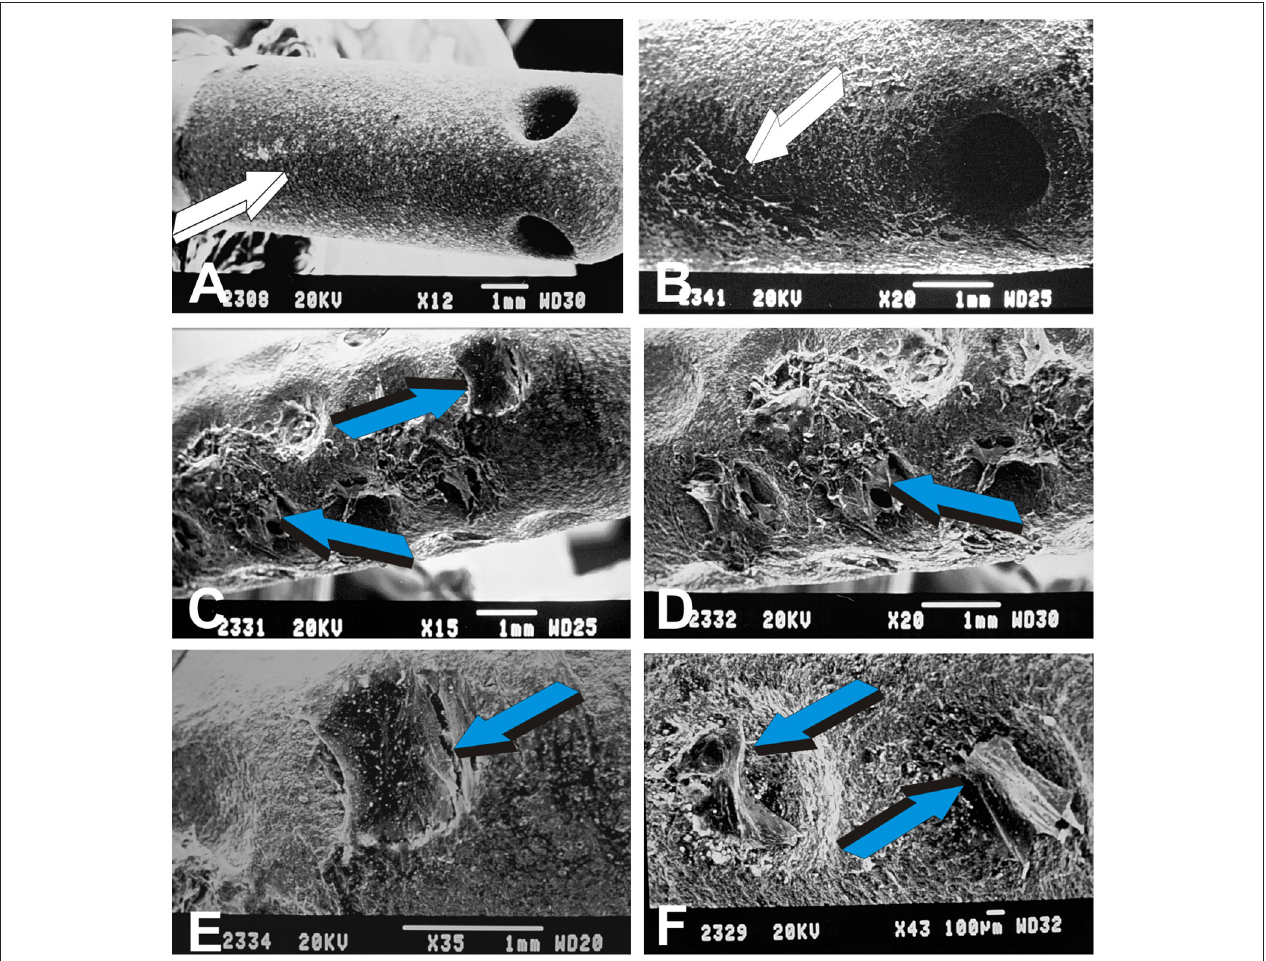
FIGURE 7 | Morphogenetic landscape of the geometric induction of tissue morphogenesis and tissue patterning by specific geometric configurations of titanium substrata coated with highly crystalline high adhesion sintered hydroxyapatite harvested 5 days after rectus abdominis implantation. (A,B) Lack of cellular differentiation and trafficking (white arrows) on planar control hydroxyapatite-coated titanium substrata. (C,D) Hyper cellularity, cellular patterning and cellular assembling (light blue arrows) along concavities of the titanium bioreactor, underlying the morphogenetic and inductive capacity of “ the concavity: the shape of life “ ( Ripamonti, 2006). (E,F) Tissue patterning and assemblages of tractional collagenic gradients across the concavities by synthesized collagen fibers from edge to edge of the elevated margins of the concavities, later transformed into intramembranous bone bridges across concavities of the highly sintered crystalline constructs as shown in (A,C)